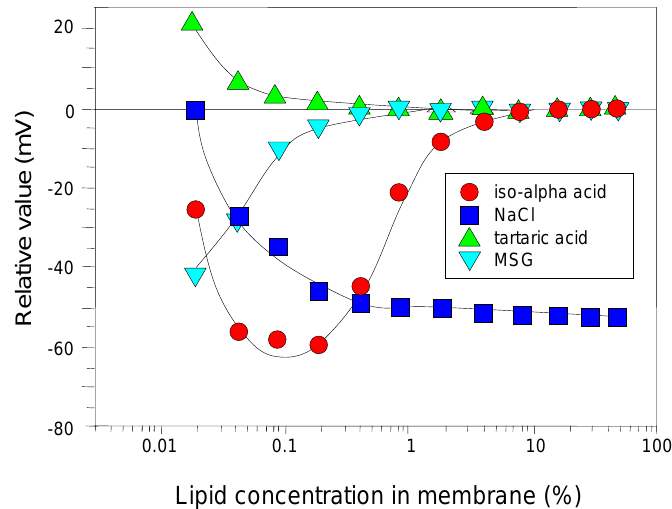
Figure 7. Relationship between lipid concentration in membrane and relative values of bitterness sensor. The concentrations of each sample are: iso-alpha acid, 0.01 vol%; NaCl, 300 mM; tartaric acid, 2.7 mM; MSG, 10 mM. All samples include 30 mM KCl and 0.3 mM tartaric acid as supporting electrolyte (Reprinted with permission from the Institute of Electrical Engineers of Japan